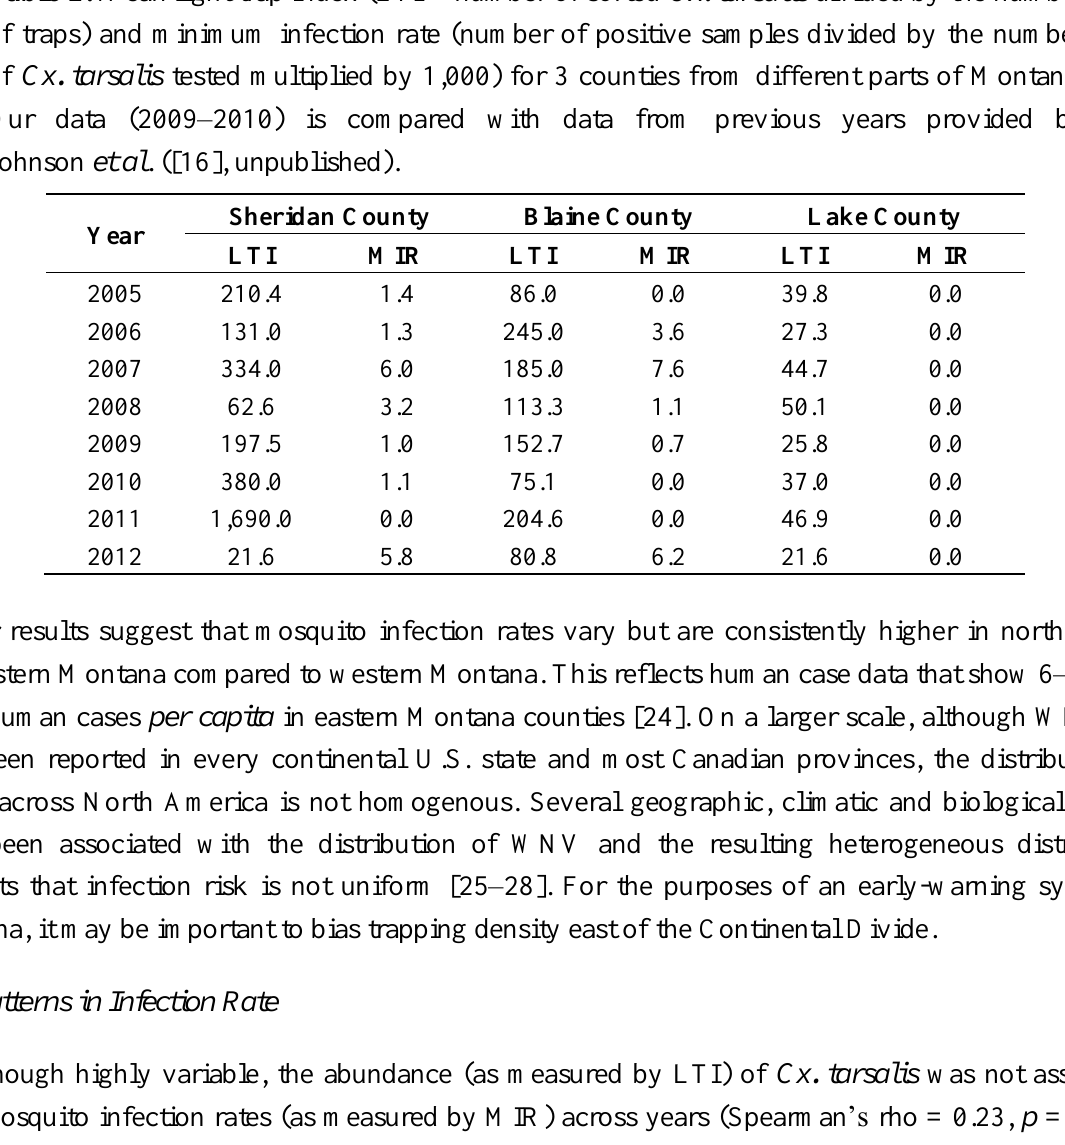
Table 2. Mean light trap index (LTI = number of sorted Cx. tarsalis divided by the number of traps) and minimum infection rate (number of positive samples divided by the number of Cx. tarsalis tested multiplied by 1,000) for 3 counties from different parts of